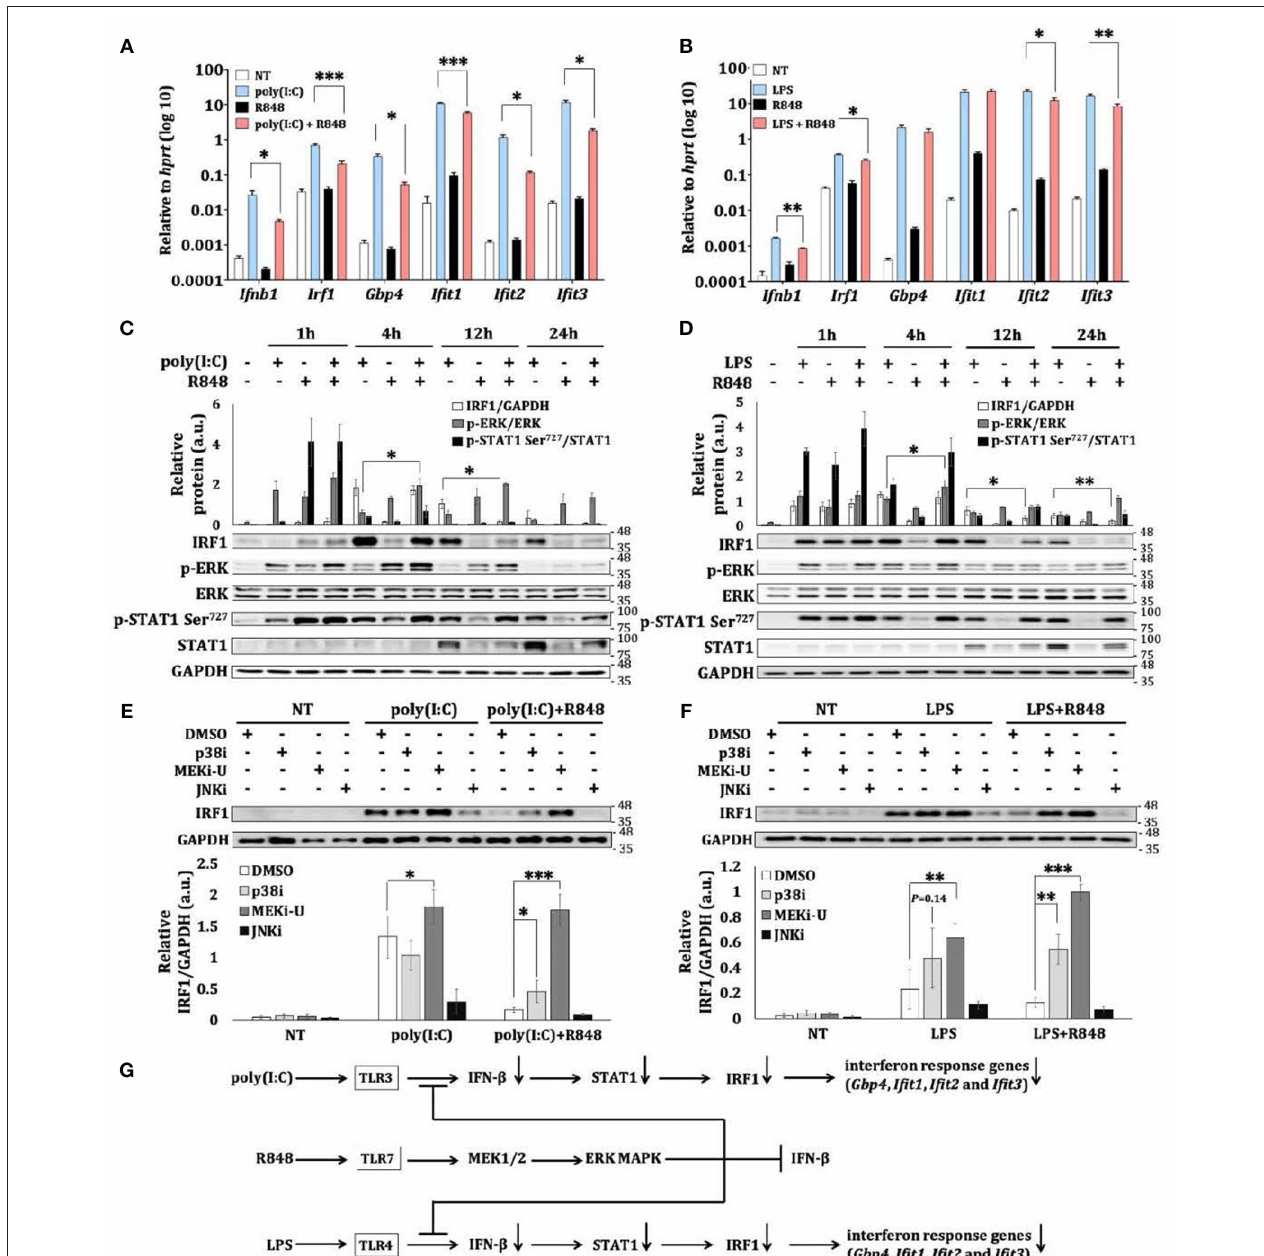
FIGURE 1 | TLR7 stimulation constrains expression of interferon response genes during TLR crosstalk in macrophages. (A,B) qRT-PCR analysis of Ifn- β , Irf1, Gbp4, Ifit1, Ifit2, and Ifit3 mRNA expression in BMDM stimulated as indicated for 12h. Data are means ± SD from 4 experiments. (C,D) Immunoblot analysis and quantitative densitometry of IRF1, total and p-ERK, total and p-STAT1 in BMDM stimulated for indicated time intervals. Blots are representative of 3 or 4 experiments. Quantified data are means ± SD from all experiments. (E,F) Immunoblot analysis and quantitative densitometry of IRF1 in stimulated BMDMs stimulated with TLR3 agonist poly(I:C) and TLR7 agonist R848 (E) , or with TLR4 agonist LPS and R848 (F) for 12h in the presence or absence of indicated MAPK inhibitors. Blots are representative of 4 or 5 experiments. Molecular weight (kDa) markers are indicated on the right side of the blots. Quantified data are means ± SD from all experiments. (G) Schematic illustration of TLR7-specific suppression on TLR3- and TLR4- induced interferon response and induction of intetferon response genes like Irf1. TLR7 also activates the MEK1/2-ERK MAPK pathway to limit itself from inducing interferon response. * P < 0.05, ** P < 0.01, and *** P < 0.001 by unpaired Welch’s t -test. Compared to vehicle control, there were 32% more differentially ( Figure 2A ). Amongst genes that were suppressed by the expressed genes after MEK1/2 inhibition ( Figure S2B ), which MEK1/2 pathway, 33 and 24% interacted with STAT1 ( Figure 2A , were then shortlisted into Activation and Suppression categories purple) or IRF1 ( Figure 2A , orange), respectively. Using